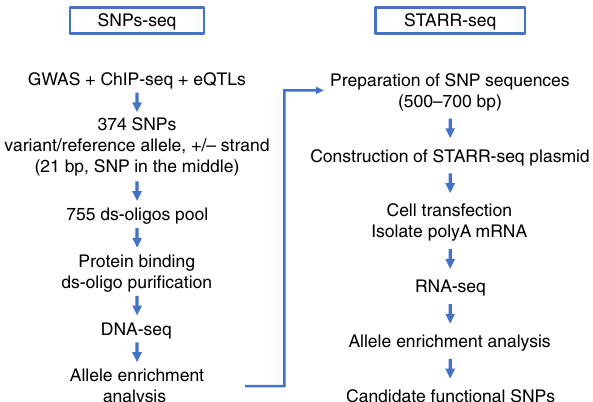
Fig. 2 Overall study design. SNPs-seq work fl ow (left panel): 374 SNPs were selected from analyzing GWAS, ChIP-seq, and eQTL data. SNP-containing oligos were synthesized, followed by annealing the positive and negative strands to make ds-oligos. By mixing ds-oligos with nuclear extract, the protein-bound ds-oligos were separated and used for library preparation and allele-speci fi c sequencing analysis. STARR-seq work fl ow (right panel): Signi fi cant SNPs selected from SNPs-seq were PCR-ampli fi ed, pooled and inserted into STARR-seq vector. After co-transfecting LNCaP cells, the mRNAs from transfected cells were isolated and used to make STARR-seq library for allele-speci fi c sequencing analysis